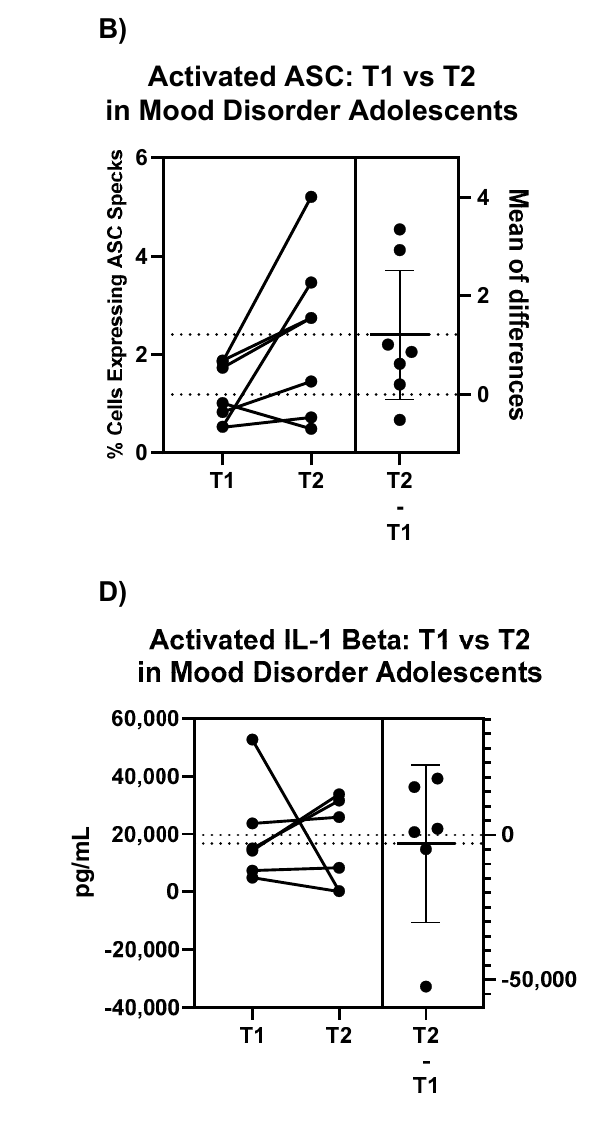
Figure 4. Paired t -test results comparing change in ASC specks in ( A ) untreated and ( B ) treated PBMC of adolescent mood disorder patients from first visit to second visit 6 months later, with corresponding change in IL-1 beta for ( C ) untreated and ( D ) treated PBMC. ASC values are intracellular and measured using immunofluorescence while IL-1 beta values are extracellular and measured using ELISA. Mean of differences are expressed as mean ± SD, all paired t -tests were not statistically significant for p < 0.05.